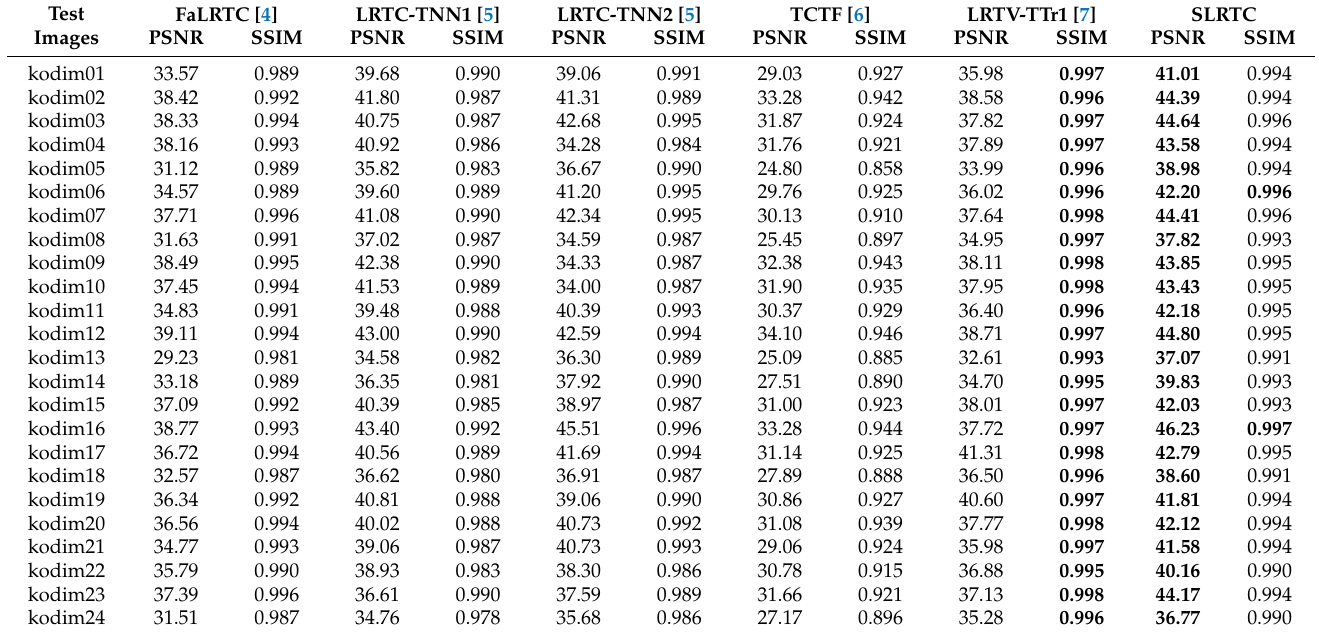
Table 2. The PSNR and SSIM Comparison of different methods on the Kodak PhotoCD dataset, the incomplete images tested contain 30 percent missing entries (The best results are